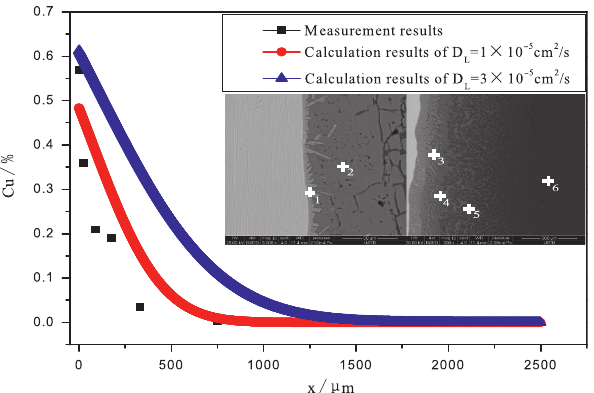
Figure 3: Actual measurement results and calculation results of the Cu